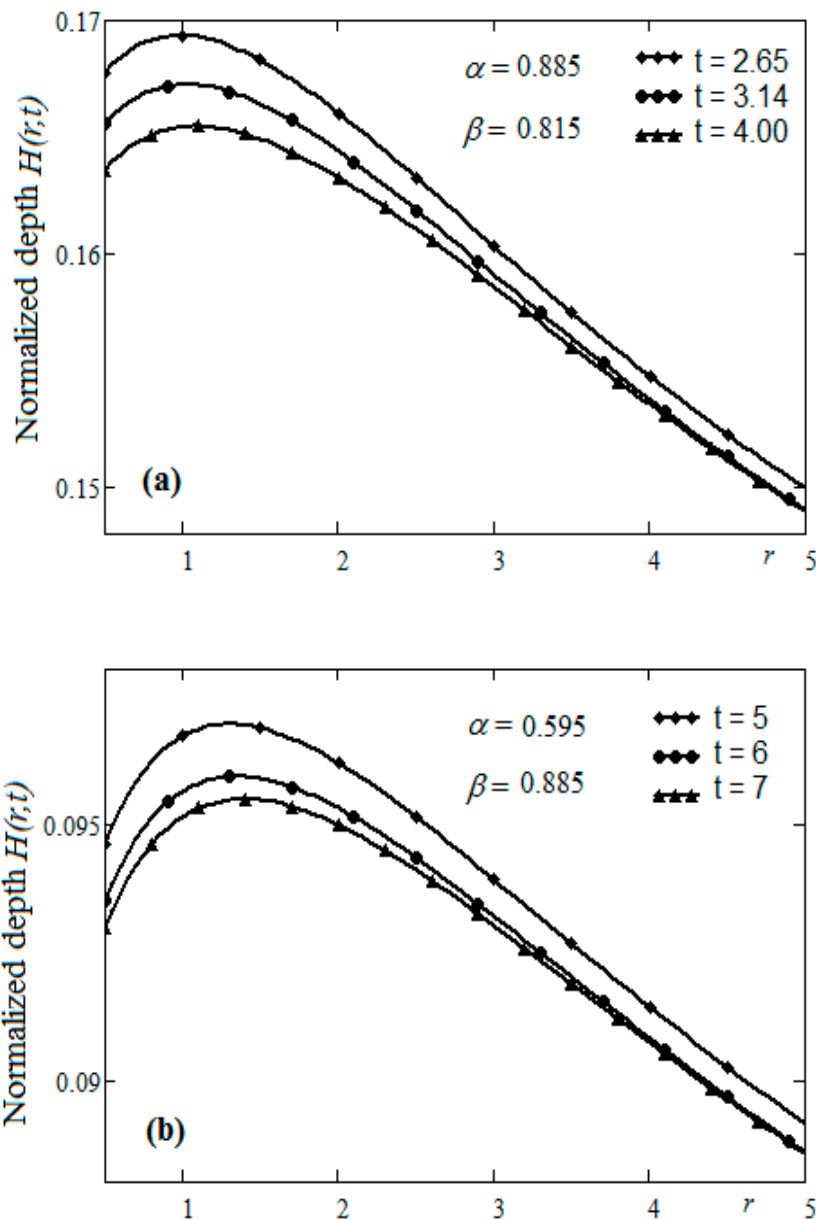
Figure 1. The profiles of normalized depth H ( r , t ) , versus the radial coordinate r , for small time values ( a ), and for large time values ( b ). The influence of the fractional parameters α and β on the normalized depth H ( r , t ) is analyzed in Figure 2 for a = 0.4 and b = 0.6 for different values of the time t . It is observed in Figure 2 that for a constant value of the fractional parameter α , the function H ( r , t ) is increasing with the fractional parameter β . A similar behavior is observed for β constant and increasing values of the parameter α . The increasing of values of a fractional parameter means that the porosity of the medium is larger; therefore the diffusion process will be enhanced. The influence of the parameter a on the normalized depth H ( r , t ) is presented in Figure 3 for t = 6 and α = 0.885 and different values of the fractional parameter β . As expected, the normalized depth decreases with the parameter a . This result is due to a larger region of the medium with big pores where the flow is